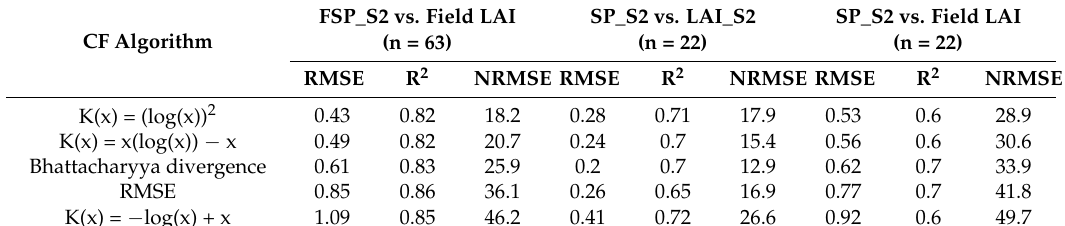
Table 8. Goodness-of-fit statistics of look-up-table (LUT) inversion using the field spectral data aggregated according to Sentinel-2 bands and the field LAI (FSP_S2 vs. Field LAI); the spectral data of Sentinel-2 images and the LAI product derived from Sentinel-2 (SP_S2 vs. LAI_S2); the spectral data of Sentinel-2 images and the field LAI (SP_S2 vs. Field LAI), while considering different cost function (CF) algorithms.